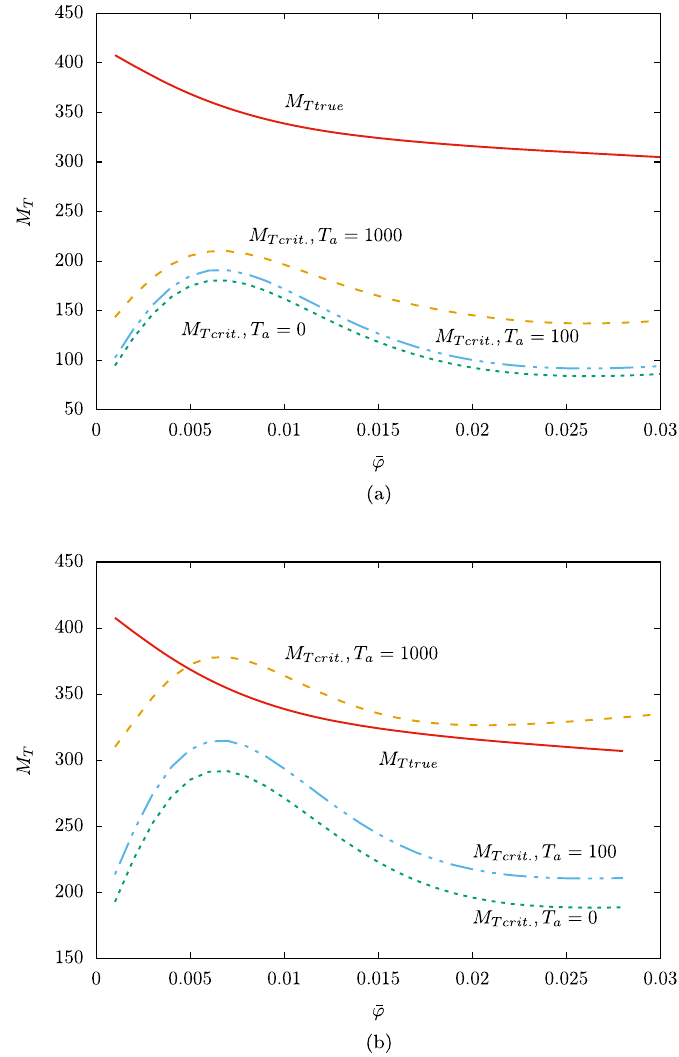
Figure 1: The true and critical temperature Marangoni numbers for DW/alumina nano fl uid with = d 30 nm p , = ∘ T Δ 2 K for average volume fractions ranging from 0.01 to 0.03. Stability boundary curves for M T are calculated based on ( a ) Model I and ( b ) Model II, using the thermal conductivity and dynamic viscosity constitutive functions proposed by Brinkman - Hamilton -